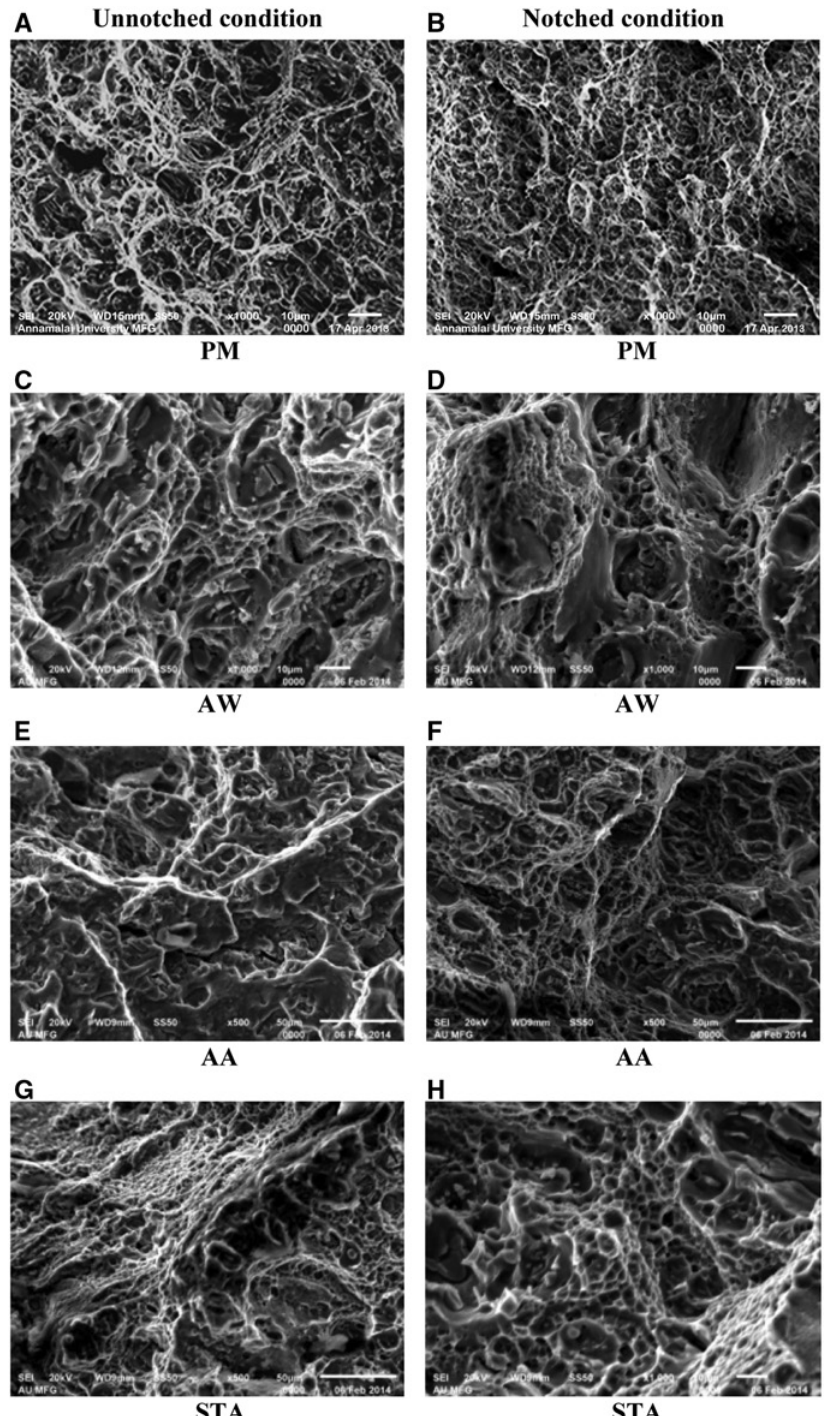
Figure 2: Fractograph of tensile specimens of the parent metal and FSW joints.